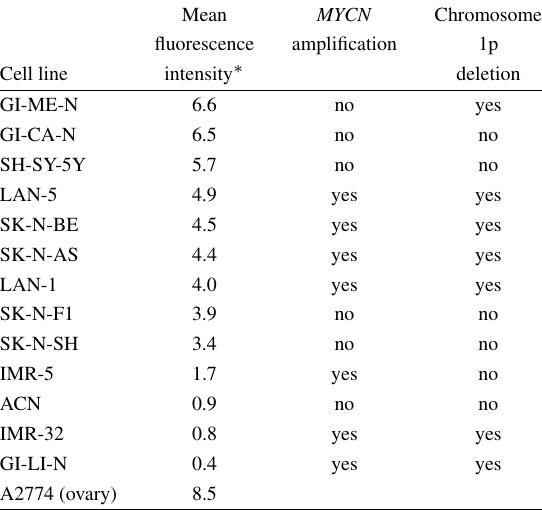
Cell surface ALCAM expression by human NB cell